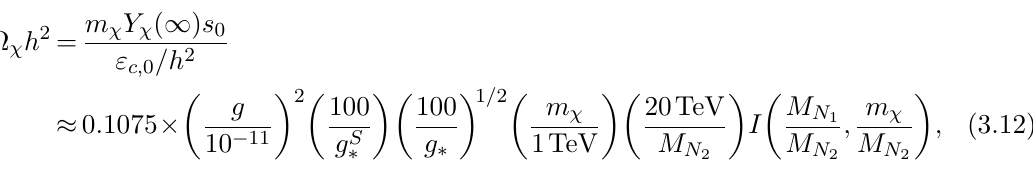
Figure 3 . The solutions of the Boltzmann equations with the masses M N m (cid:31) = 1 TeV and the Yukawa coupling g = 10 (cid:0) 11 . The black solid lines indicate the yields in the thermal equilibrium, Y eq . The decay parameters D i = (cid:0) N N i left panel, the decay parameters are unity. In the right panel, the decay parameters are hierarchical and tiny